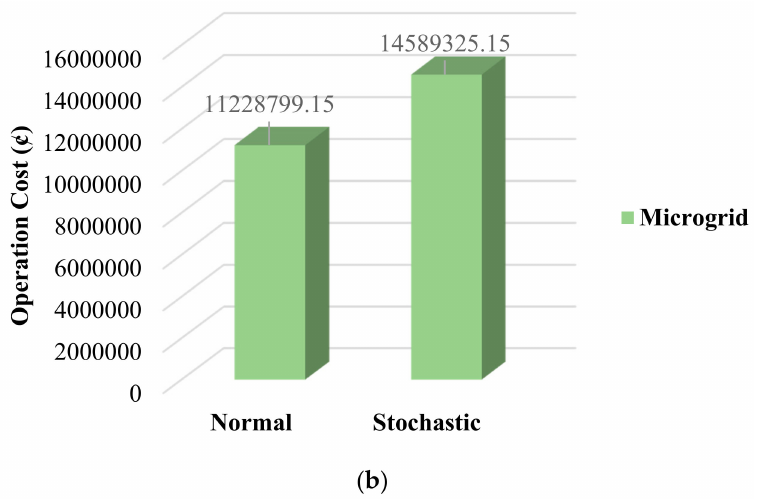
Figure 19. The operation costs of smart grid ( a ) and microgrid ( b ) in stochastic and normal conditions.